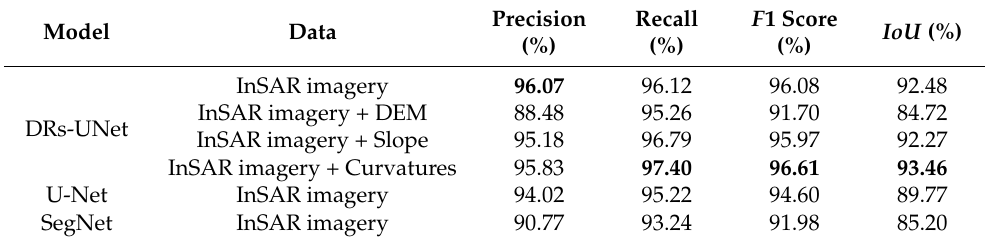
Table 3. Evaluation of the active landslides extraction results on the test dataset.